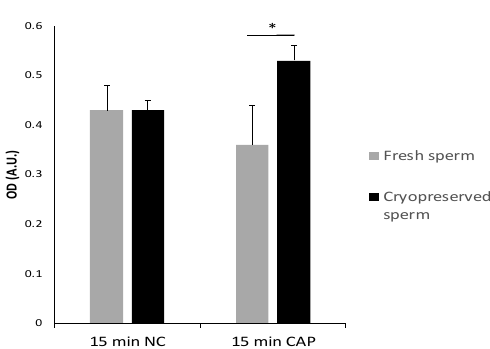
Figure 2. Optical densities (OD) of CAPZA2 in fresh and cryopreserved sperm after 15 min of incubation in NC or CAP conditions assessed using ELISA. * p < 0.05.